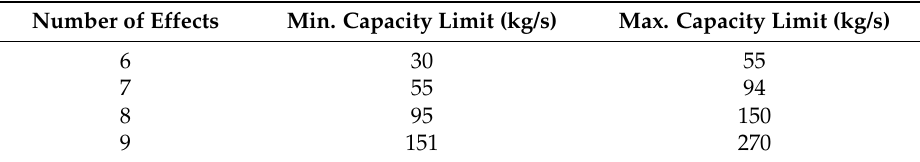
Table 3. Number of effects optimal policy for various MED capacities.